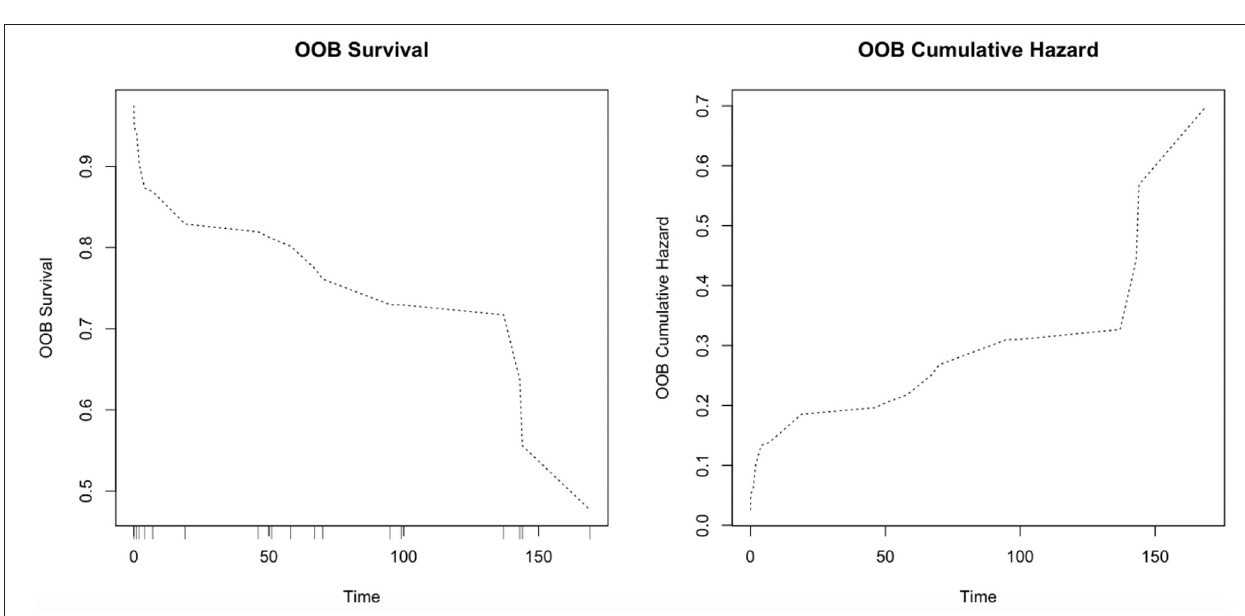
FIGURE 3 | Predicted OOB survival ( Left ) and cumulative hazard ( Right ) curves generated from the RSF model to predict VT/VF